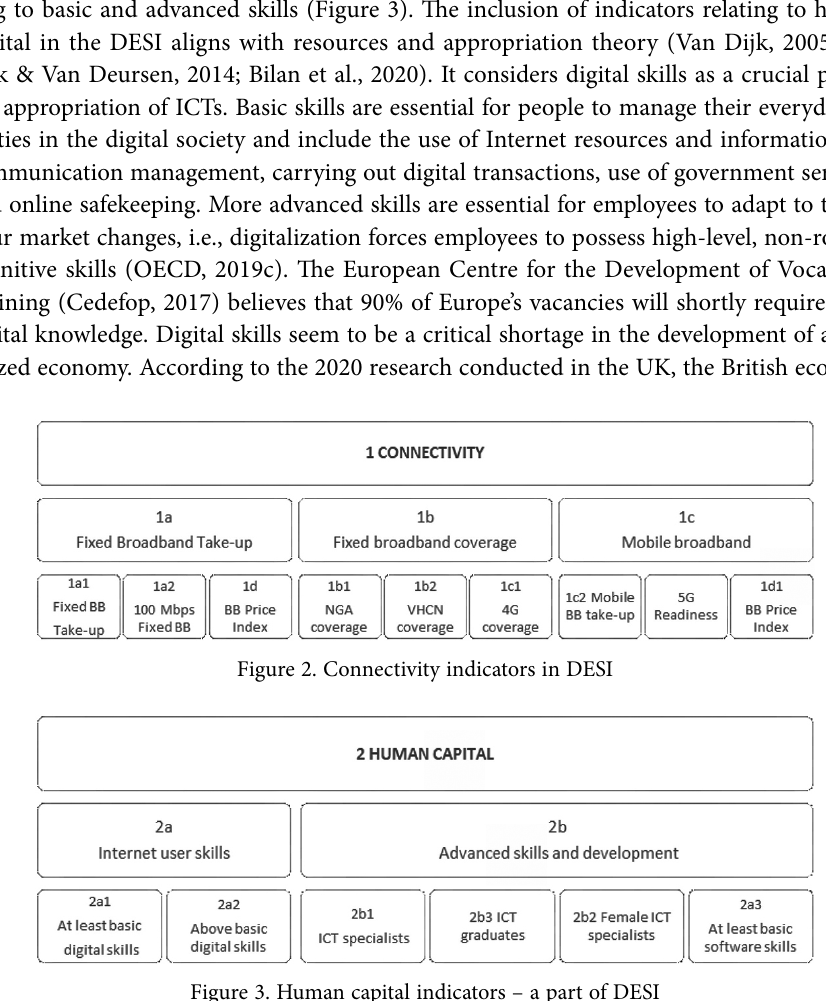
Figure 3. Human capital indicators – a part of